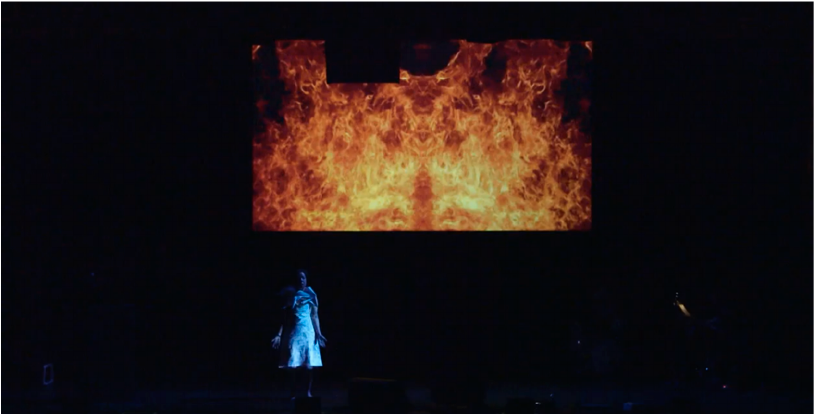
Figure 15. Shin Yu Pai with collaborator Scott Keva James’s two-channel video lighting up the stage.